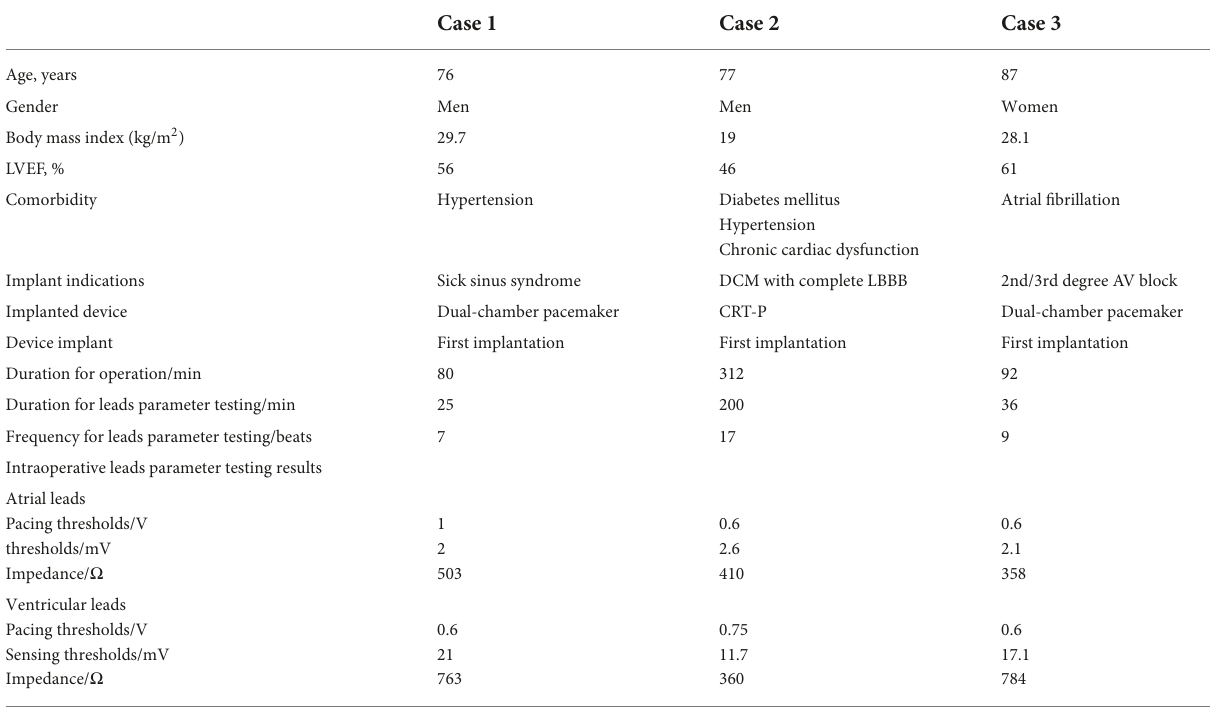
TABLE 1 Clinical characteristics of the enrolled